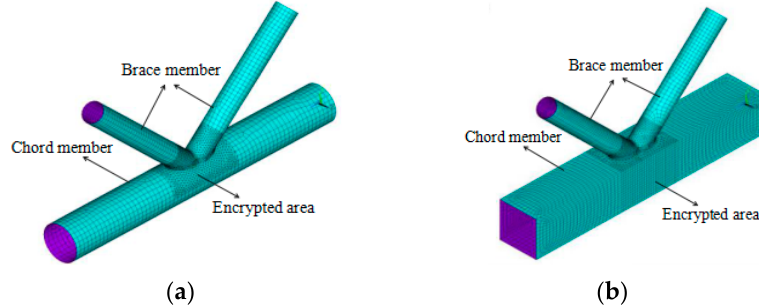
Figure 9. Finite element model of a joint. ( a ) K-CC; ( b ) K-RC.